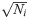
Nearest neighbor distance distribution (NNDD) in the BCI tropical forest.For every species, the graph presented is a normalized histogram of the distances from every tree to its closest conspecific tree in the forest [28]. In panel (A) the data is presented for the 15 most abundant species on a semi-log scale. The decay at long distances is clearly exponential, but the slope varies strongly among species. Panel (B) shows the same data when distances are rescaled by ℓ
0, showing a good data collapse in the exponential regime. Panels (C) and (D) are the same graphs for all species with >50 individuals in the forest. The data is noisier, but the pronounced features are the same. In panel (E), the slope α in the exponential regime is plotted against the abundance of the species N
i, showing a Ni dependence as expected (red line, notice the logarithmic scale). This correlation is much weaker, and almost disappears for N
i < 150 when the rescaled data is analyzed (panel (F), α* is the slope measured in rescaled coordinates).